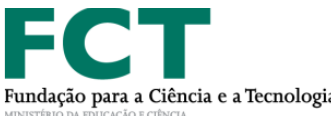
Figure 13. 3D response surface plots for thin-walled tubes: ( a ) melt thickness model and ( b ) thick- ness model.